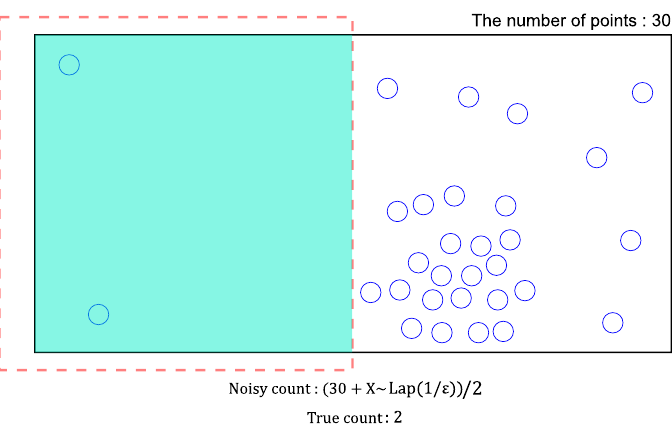
Figure 2. Two different grid PSDs in the same spatial domain.